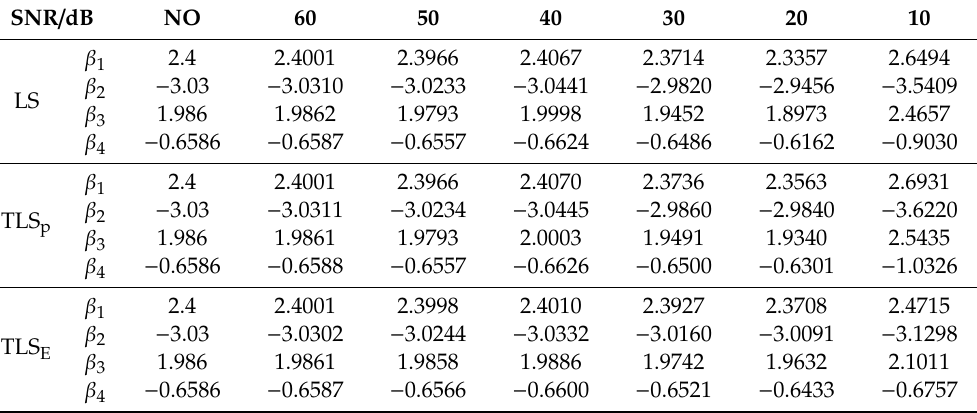
Table 1. Values of parameter